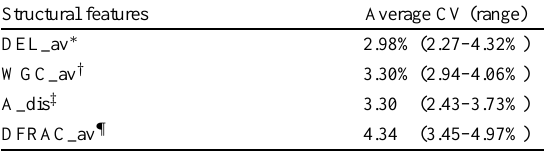
The total of 27 structural features, with their corresponding num- ber of cells at which the CV was less than 5%, and the CV at 5000 cells analysed. The data shown are from 4 separate cases of normal oral mucosa. Similar data (not shown) were found in carcinomas of the tongue and cervix. All but one of the features (DEL_av) re- quire more than 1000 cells analysed in order to achieve reproducible values (CV < 5%). Thirteen of the investigated structural features require more than 1500 cells in order to achieve reproducible